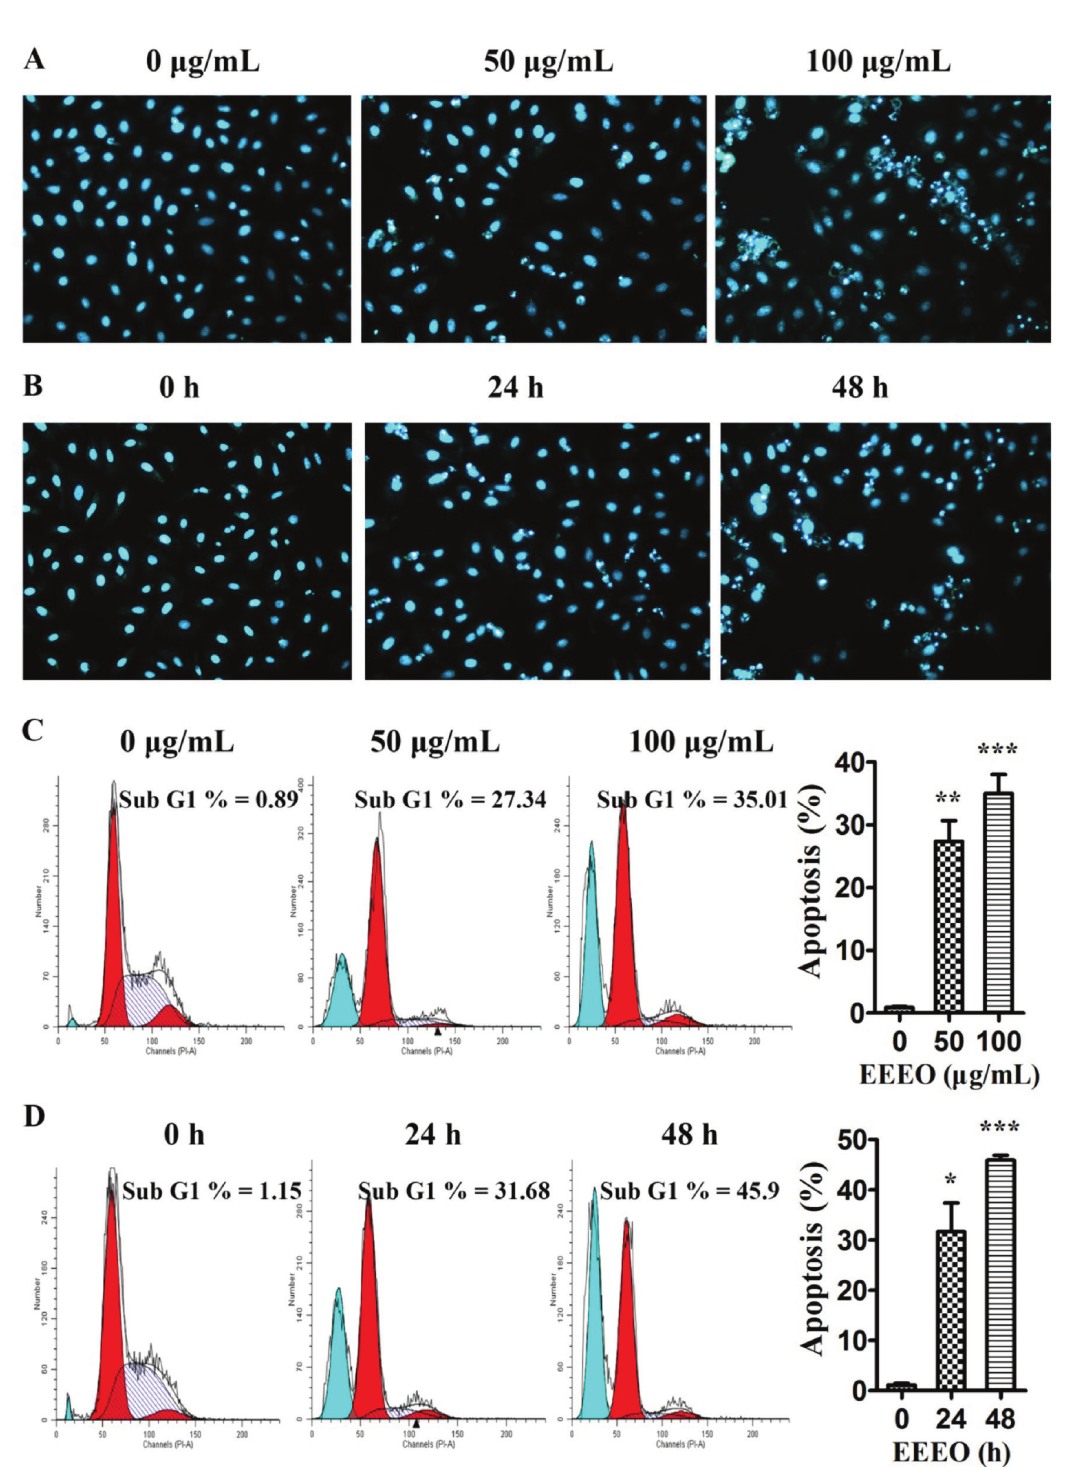
FIGURE 3 - EEEO dose- and time- dependently provoked human HepG2 cell apoptosis in vitro . (A) HepG2 cells were treated with 0, 50 and 100 μg/mL of EEEO. After 24 h, cell was observed under phase contrast microscope. (B) As time grows (0, 24 and 48 h), cells were also observed under phase contrast microscope (50 μg/mL of EEEO). (C) HepG2 cells were treated with 0, 50 and 100 μg/mL of EEEO for 24 h. Then, cell apoptosis was observed by FASC. (D) HepG2 cells were treated with 100 μg/mL EEEO for 0, 24 and 48 h times. Then, cell apoptosis was examined by FACS. 0 μg/mL (or 0 h) of EEEO treatment served as control group. The data are shown as the means ± SD from three independent experiments. * P < 0.05, ** P < 0.01 and *** P < 0.001 vs. control. Results are representative of three independent